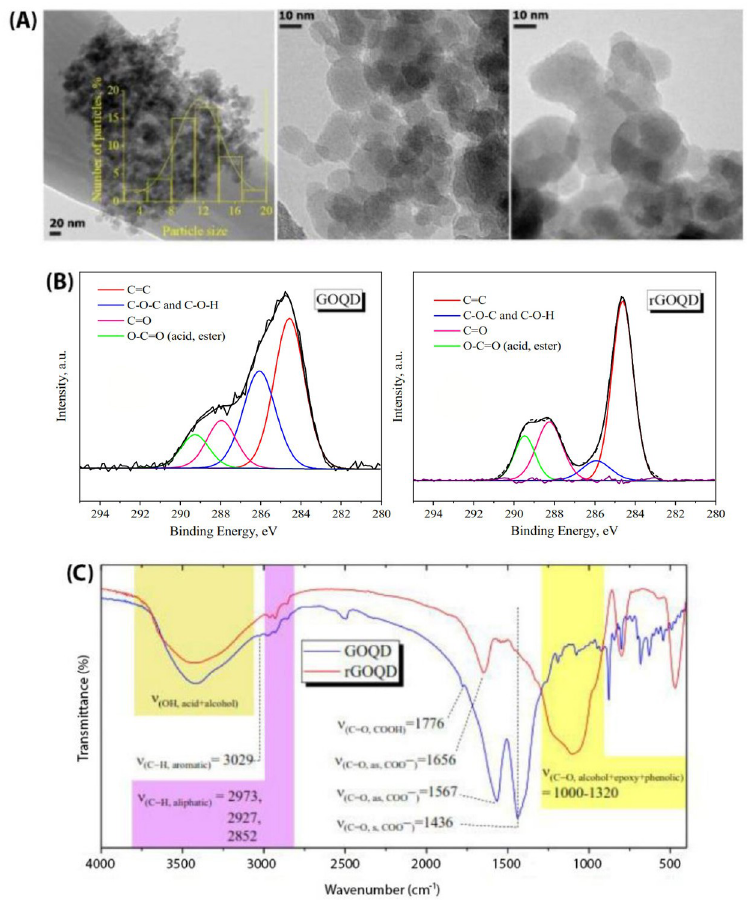
Fig 2. Microscopic and spectroscopic characterizations of GOQDs and rGOQDs. (A) TEM images of 0.02 mg/ml GOQDs at different magnifications (inset shows the size distribution of GOQDs); (B) The XPS C1s spectra of GOQDs and rGOQDs, and (C) FT-IR spectra of KBr pellets of GOQDs and